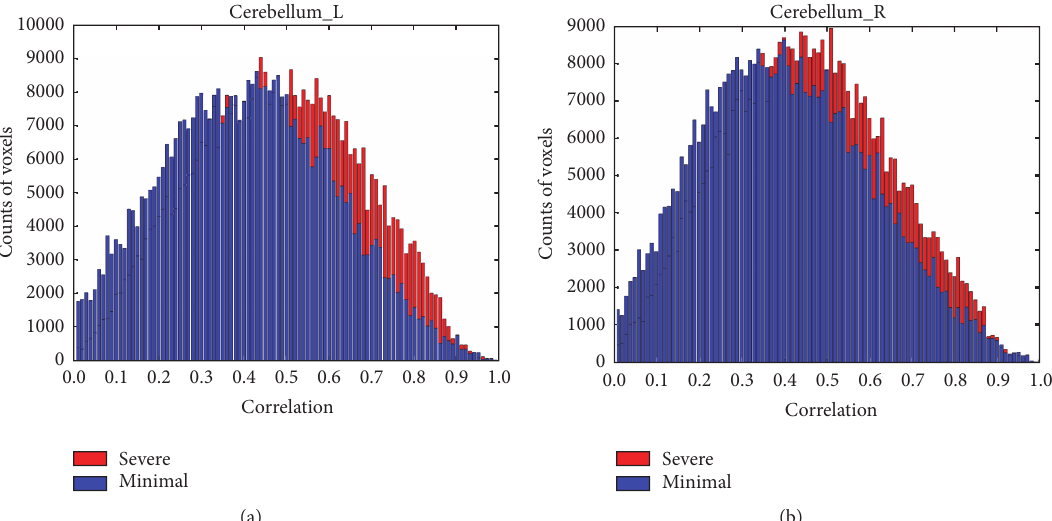
Figure 3: Comparisons of histogram plots of correlation coefficients over all subjects in cerebellum. Blue bins = data for minimal fatigue stage. Red bins = data for significant fatigue stage. Voxels with very low correlation (𝑟 < 0.001) were excluded for better visualization of coefficient distribution of the voxels in each ROI. In the significant fatigue stage, a larger number of voxels (red bins) can be seen with higher correlation (FC with seed area) values in mid-to-high correlation range in bilateral cerebellum ROIs.